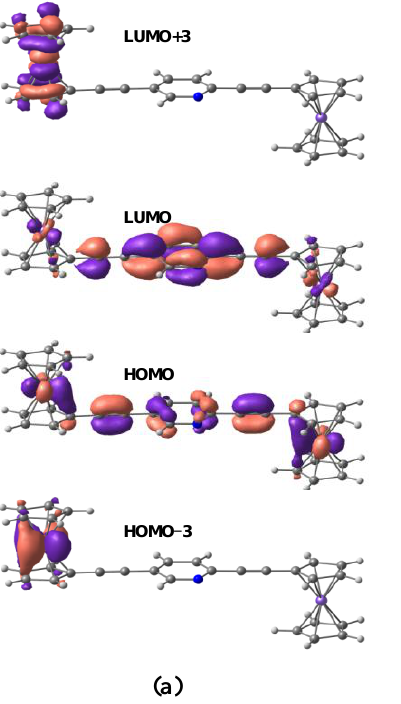
= 523 nm for compound 2 in CH max